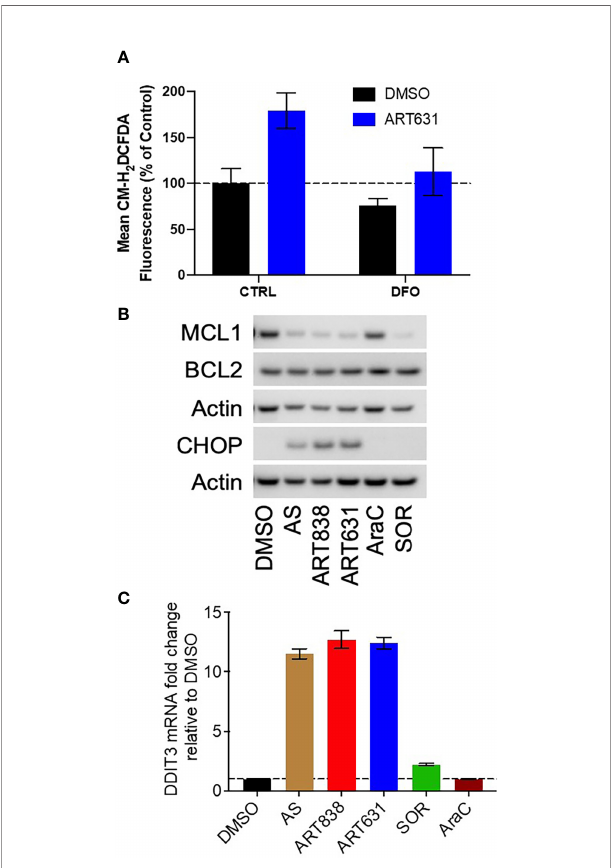
FIGURE 4 | ART631 elevated ROS and CHOP levels and reduced MCL1 expression in MOLM14 AML cells. (A) MOLM14 AML cells were pre-treated with ROS detection reagent CM-H2DCFDA (5 mM) for 30 min, pre-treated with deferoxamine mesylate (DFO; 11 mM) for 60 min, and then treated with ART631 (200 nM) or DMSO control for 18h. They were then analyzed by fl ow cytometry. Graph represents %CM-H2DCFDA fl uorescence compared to vehicle (DMSO) control treated cells. Error bars represent SD from 3 independent experiments. (B) MOLM14 AML cells were treated for 18h with vehicle, AS (10 uM), ART838 (200 nM), ART631 (200 nM), cytarabine (AraC; 150 nM), or SOR (5 uM). Protein was isolated and western blotted for MCL1, BCL2, CHOP, and b -actin. (C) MOLM14 cells were treated as in (B) for 18h, total RNA isolated, cDNA synthesized, and SYBR Green qRT-PCR performed in triplicates. Ct values were normalized to housekeeping gene GAPDH and fold change shown relative to vehicle (DMSO) control. Error bars represent SD from 3 independent experiments done in